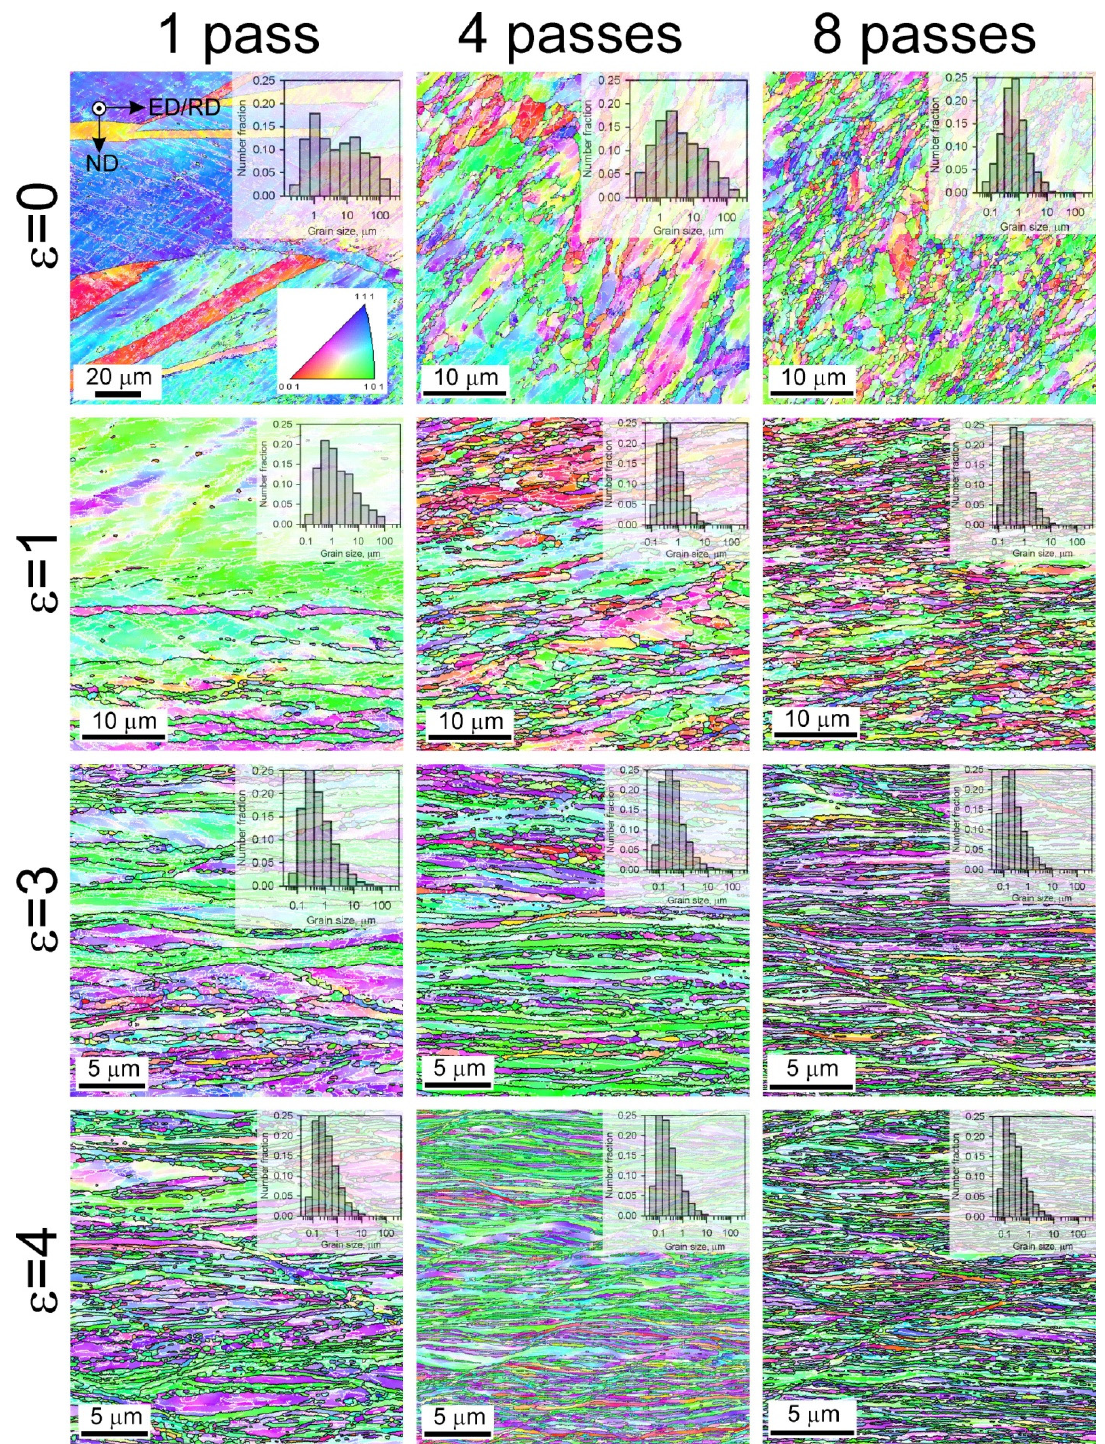
Figure 2. Deformation microstructures including the grain size distributions evolved in a Cu- Cr-Zr alloy during 1 to 8 passes of ECAE-Conform followed by cold rolling to a strain of 1 to 4. Colors indicate crystallographic directions along the normal direction (ND). ED and RD indicate the extrusion direction and the rolling direction, respectively. The black and white lines indicate high-angle ( θ ≥ 15 ◦ ) grain boundaries and low-angle (2 ◦ ≤ θ < 15 ◦ ) sub-boundaries,